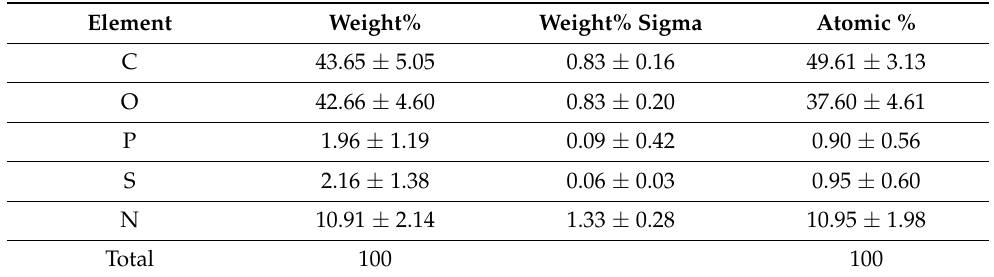
Figure 8. SEM images showing ( A ) B. haynesii CamB6 cells producing melanin-like compound in MB at 96 h of incubation, ( B ) extracted melanin-like compound 1000 × , and ( C ) at 5000 × showing high density, compact, amorphous deposit with no definite pattern. ( D ) Elemental analysis of the melanin showing the presence of C, O, N, P, and S (inset pigment at 1000 × ). Table 2. EDS elemental composition of the melanin-like deep brown pigment produced by B. haynesii